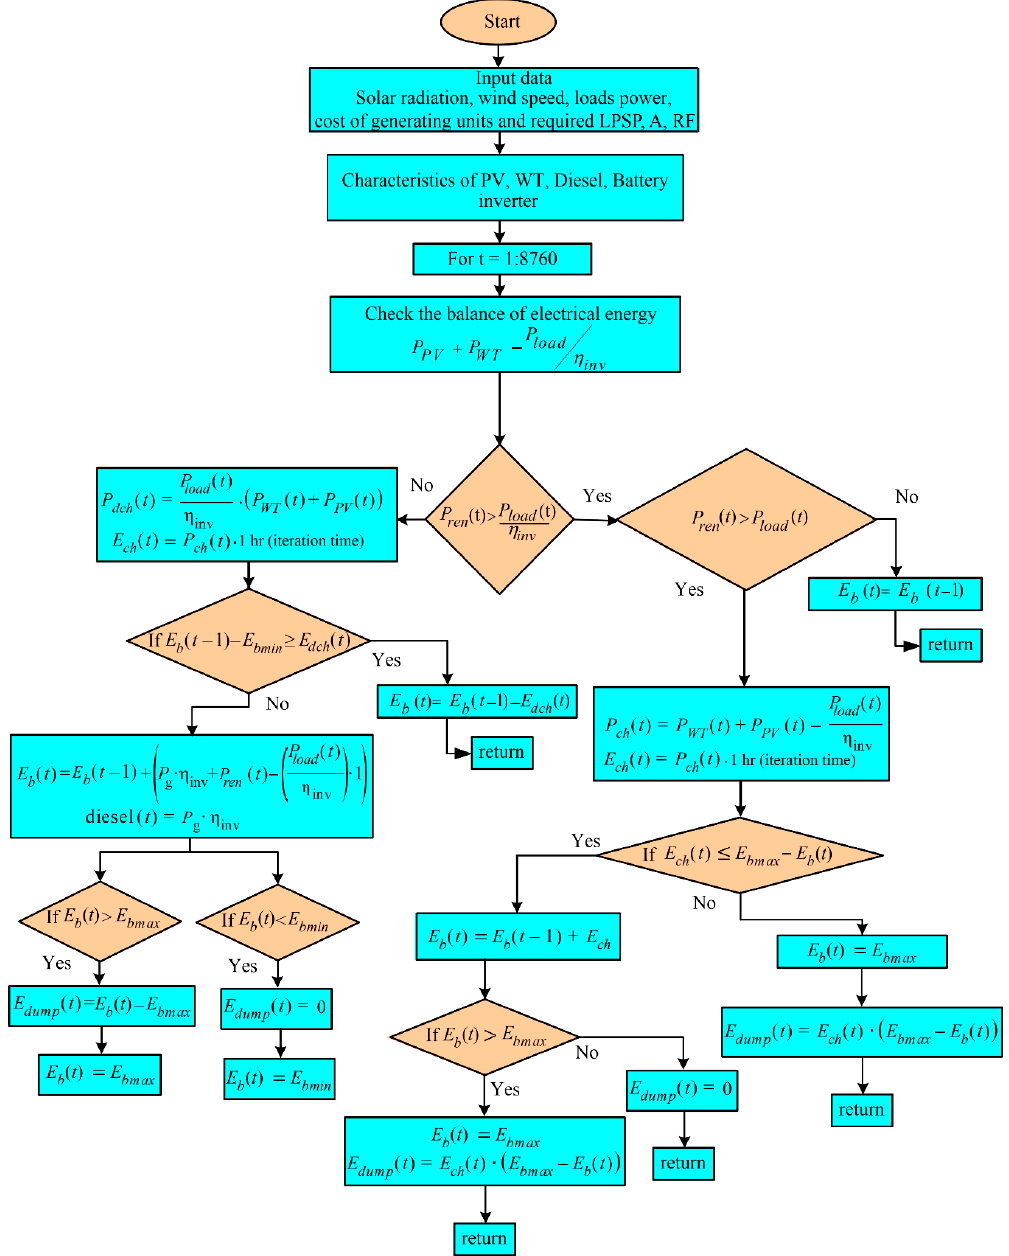
Figure 3. Power management of the PV/WT/diesel/battery energy storage system (BESS), Figure3. PowermanagementofthePV / WT / diesel / batteryenergystoragesystem(BESS),PV / diesel / BESS PV/diesel/BESS and WT/diesel/BESS hybrid RES. and WT / diesel / BESS hybrid